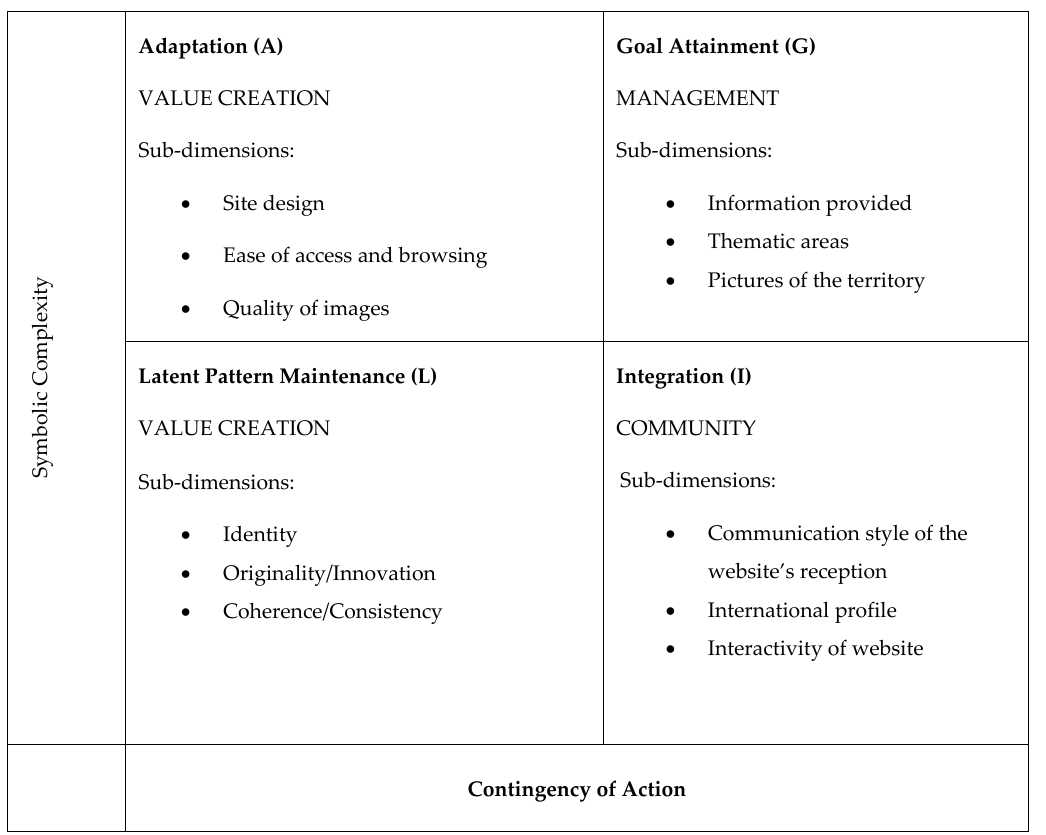
Figure 1. AGIL scheme with dimensions and sub ‐ dimensions selected for the study. Source: Adapted from T. Parsons’ model [47]. This matrix can be read clockwise starting from A.